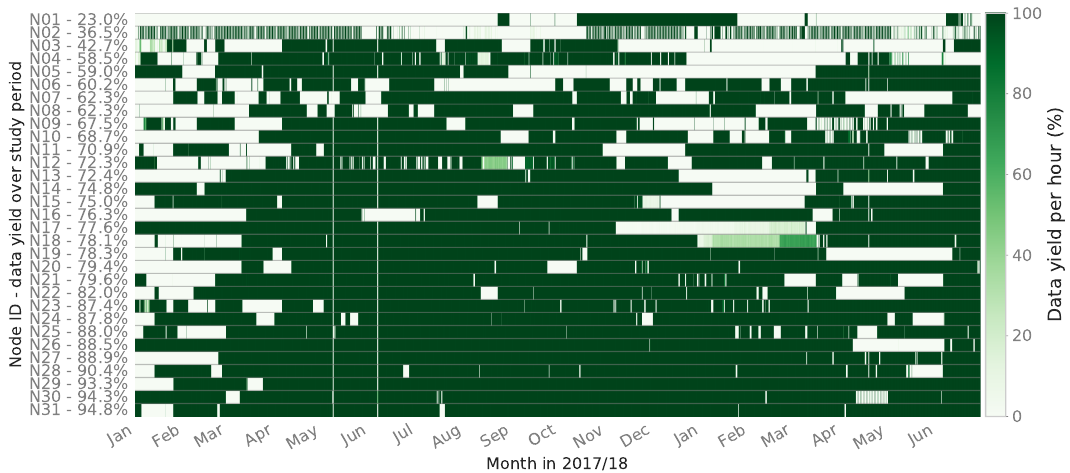
Figure 10. Sensor network data yield percentage by hour (January 2017–July